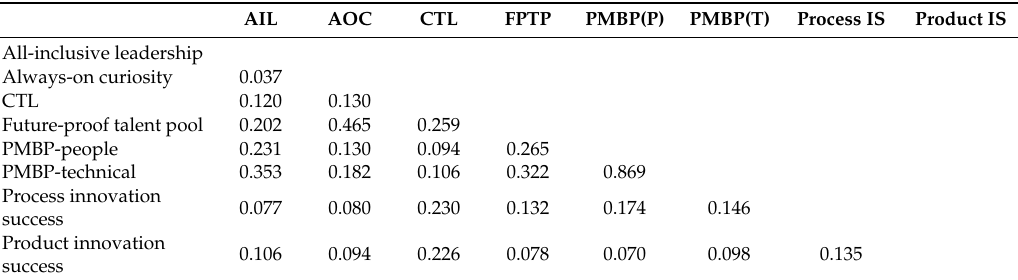
Table 4. Discriminant validity